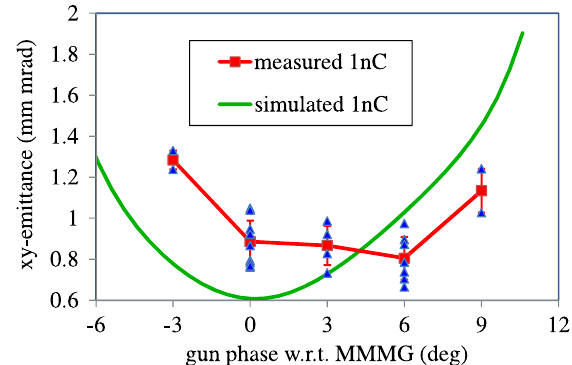
FIG. 16. Measured and simulated mean momentum and rms momentum spread as a function of gun (upper plot) and booster (bottom plot) phase. Results of two simulation setups are shown correspondinglaserrmsspotsizeatthephototcathode:‘‘simul.(1)’’, with (cid:2) l xy ¼ 0 : 32mm , and ‘‘simul. (2)’’, with (cid:2) l xy ¼ 0 : 4 mm .